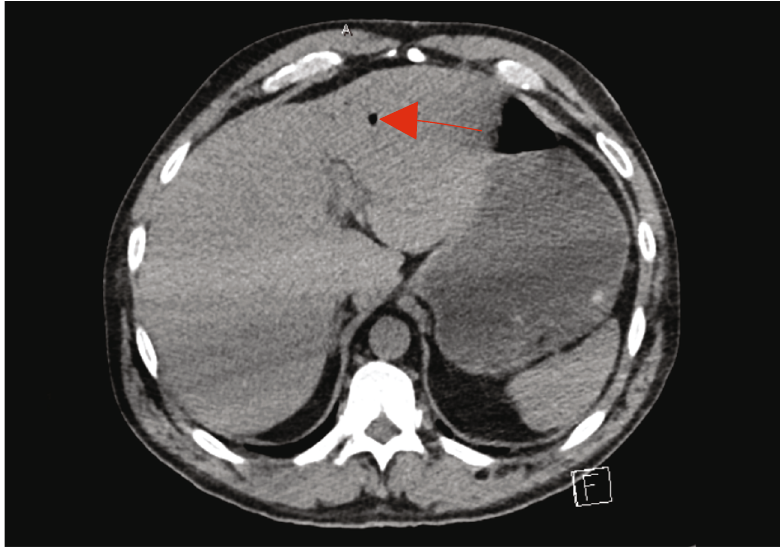
Figure 1: Noncontrast computed tomography with evidence of portal venous gas.